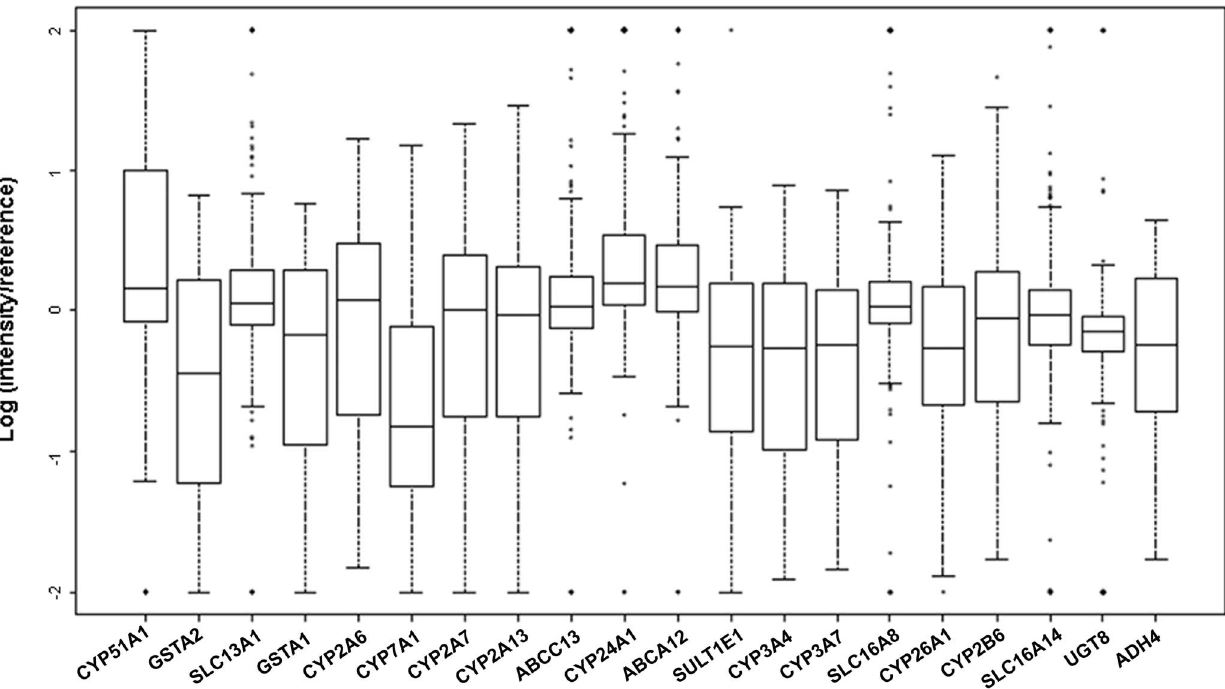
Figure 2. Box plot of the top 20 most variably expressed human hepatic DMET genes. The bottom and top of the boxes represent the 25th and 75th percentiles, respectively. The median is indicated by a bold line. The length of the box is the interquartile range (IQR). Values more than 1.5 IQRs are labeled as dots. The X-axis indicates names of DMETs, and the Y-axis indicates ‘‘Log10 Ratio of Intensity (samples/references). The reference is the pooled RNA derived from 192 liver samples selected fro sex balance from Vanderbilt and Pittsburgh samples [10].